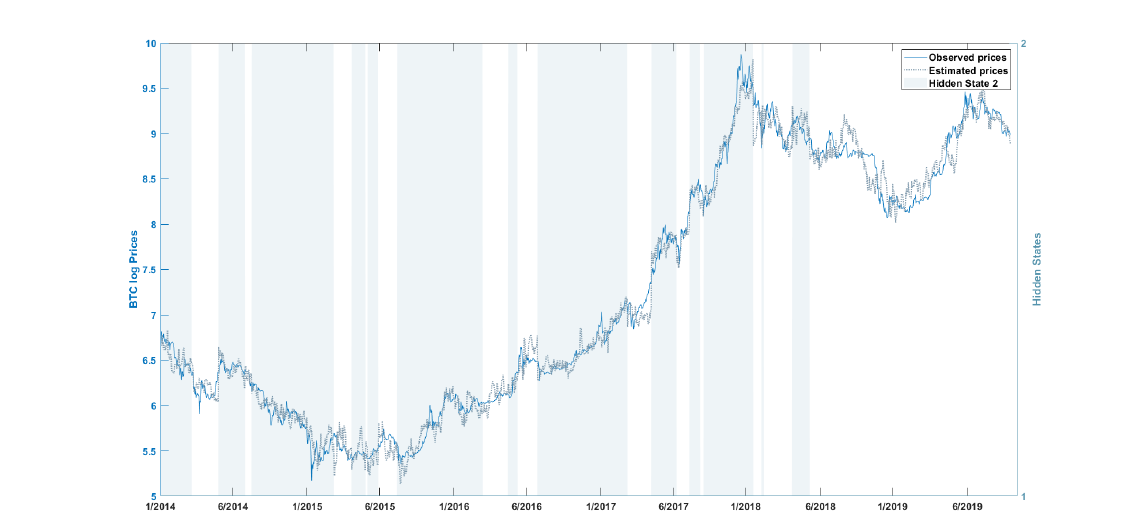
Figure 5. Logarithmic BTC prices series (blue line) and in-sample estimated logarithmic BTC price series for the period 5/2013–5/2019 (gray dotted line). Shaded bars mark times with hidden state 1 (smoothed probability above 0.5). The change of the sample sizes has a significant impact on the distribution of the unobserved process.